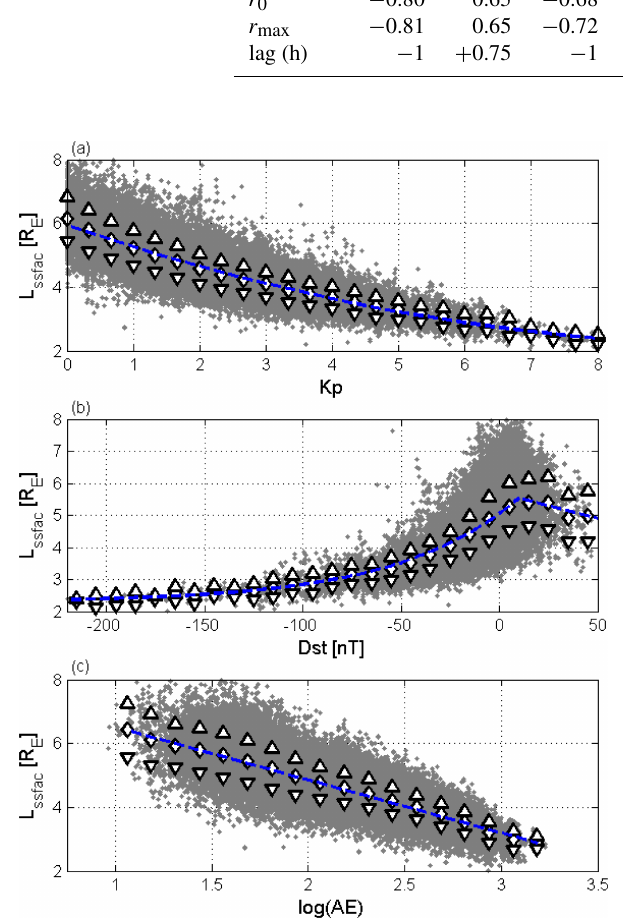
Figure 4. (a) Kp, (b) Dst, and (c) log(AE) dependence of the SS- FAC